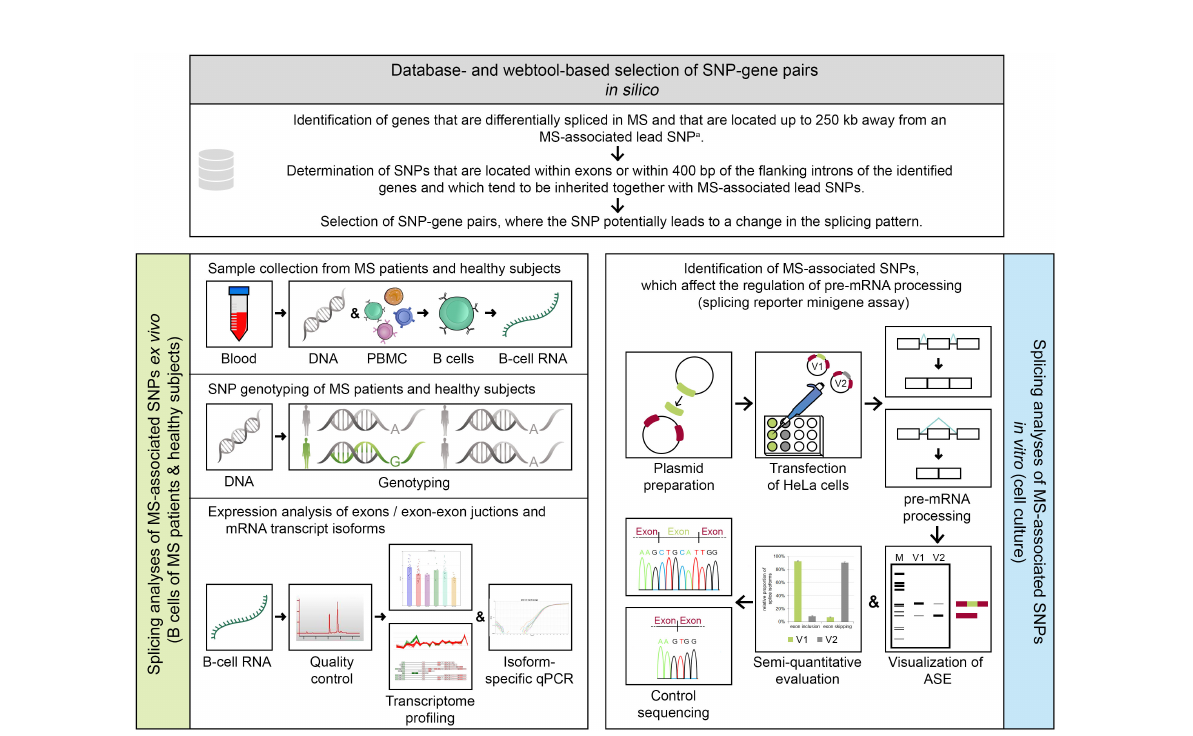
FIGURE 1 Methodical overview of the study. An in silico approach (serial work fl ow) was employed to identify single-nucleotide polymorphism (SNP) – gene pairs, where the SNP has the potential to alter the splicing pattern of a gene. For the selected SNP – gene pairs, ex vivo and in vitro analyses were conducted. a Multiple sclerosis (MS) – associated lead SNP according to the genome-wide association study (GWAS) of MS from 2019 (32). ASE, alternative splicing event; bp, base pairs; GWAS, genome-wide association study; kb, kilobases; MS, multiple sclerosis; PBMC, peripheral blood mononuclear cells; qPCR, quantitative real-time PCR polymerase chain reaction; SNP, single-nucleotide polymorphism; V1/V2, minigene construct variants, which differ in only one base and thus represent the two allelic variants of a SNP (here, V1 shows constitutive splicing and V2 shows alternative